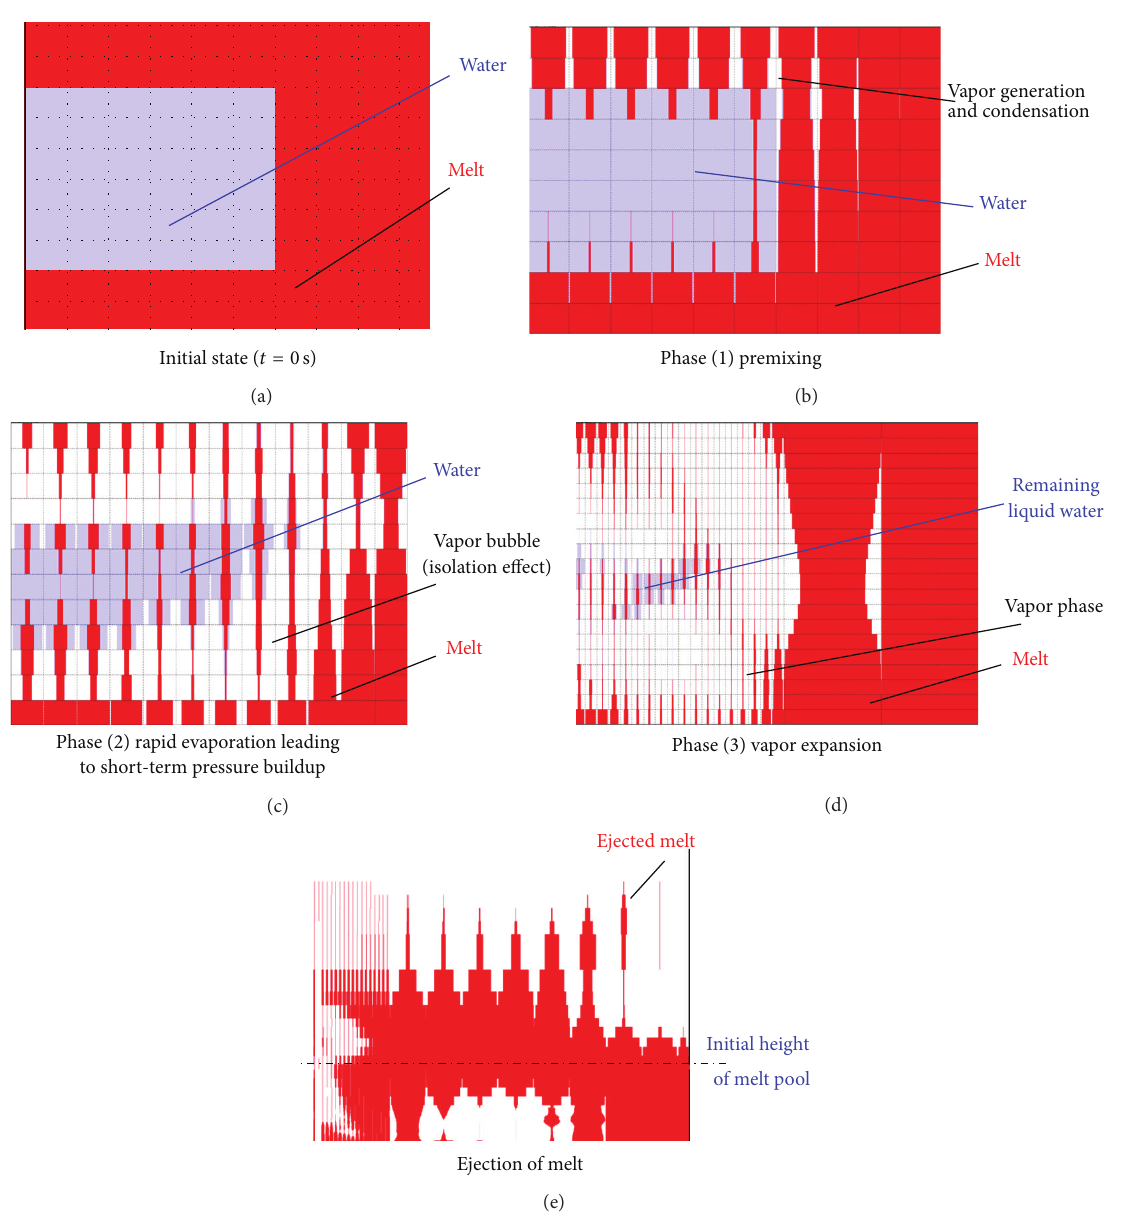
Figure 9: Material distribution in several representative frames for Run